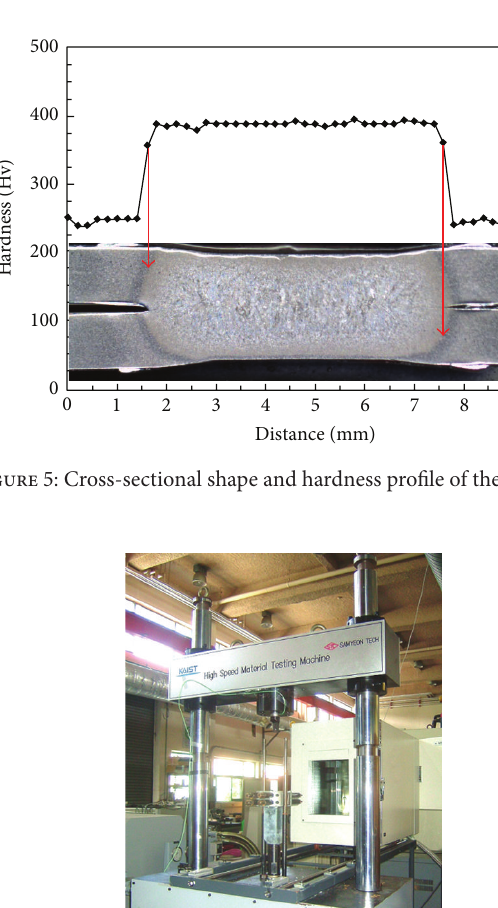
Figure 4: Specimens used in the failure test: (a) combined loading tests at loading angles of 0 ∘ , 15 ∘ , 30 ∘ , 45 ∘ , 60 ∘ , and 75 ∘ ; (b) pure shear tests at loading angle of 90 ∘ .